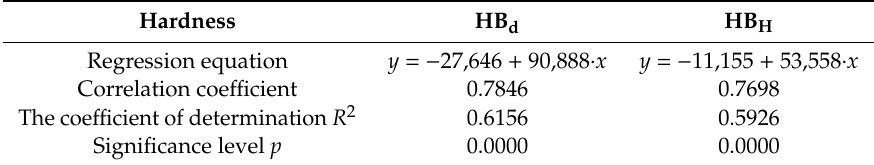
Table 5. Results of the regression analysis for hardness versus density.